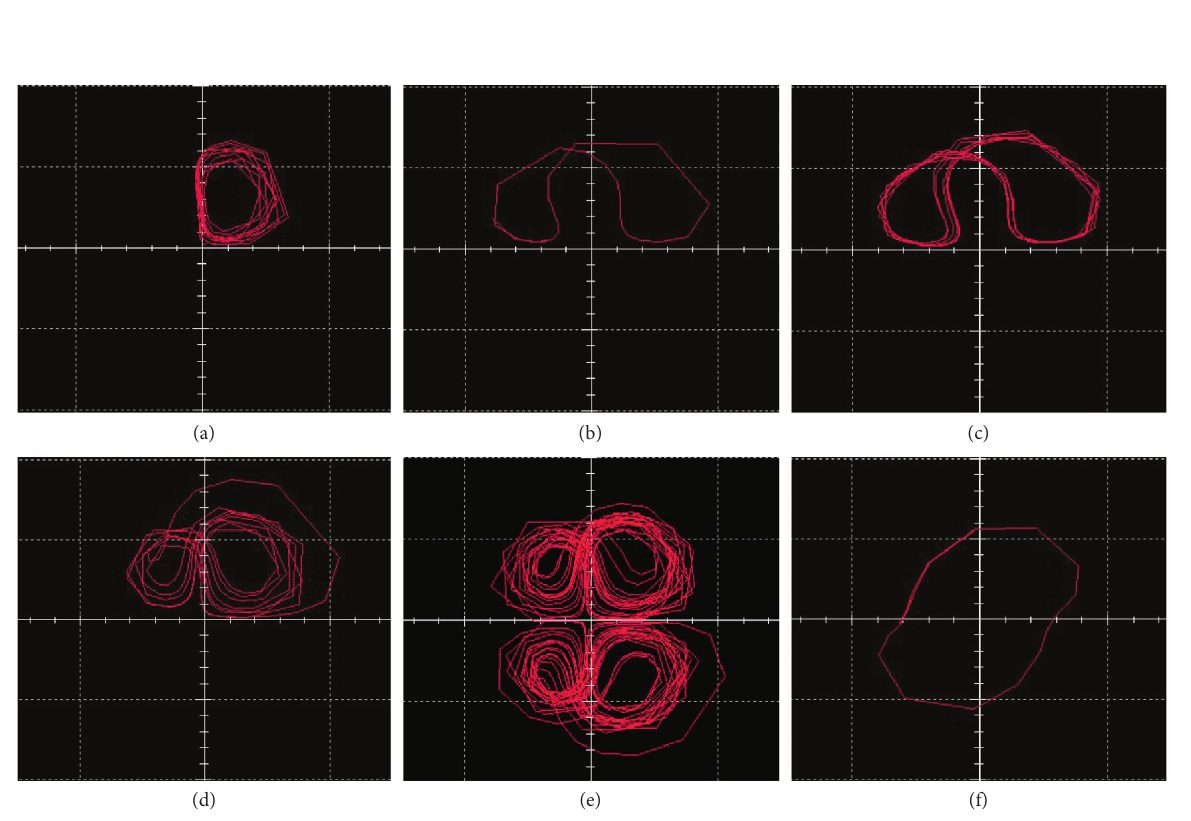
Figure 11: The circuit simulation diagram of system (4): (a) one-wing multiperiod, (b) period-1, (c) two-wing multiperiod, (d) two-wing, (e) four-wing, and (f) limit